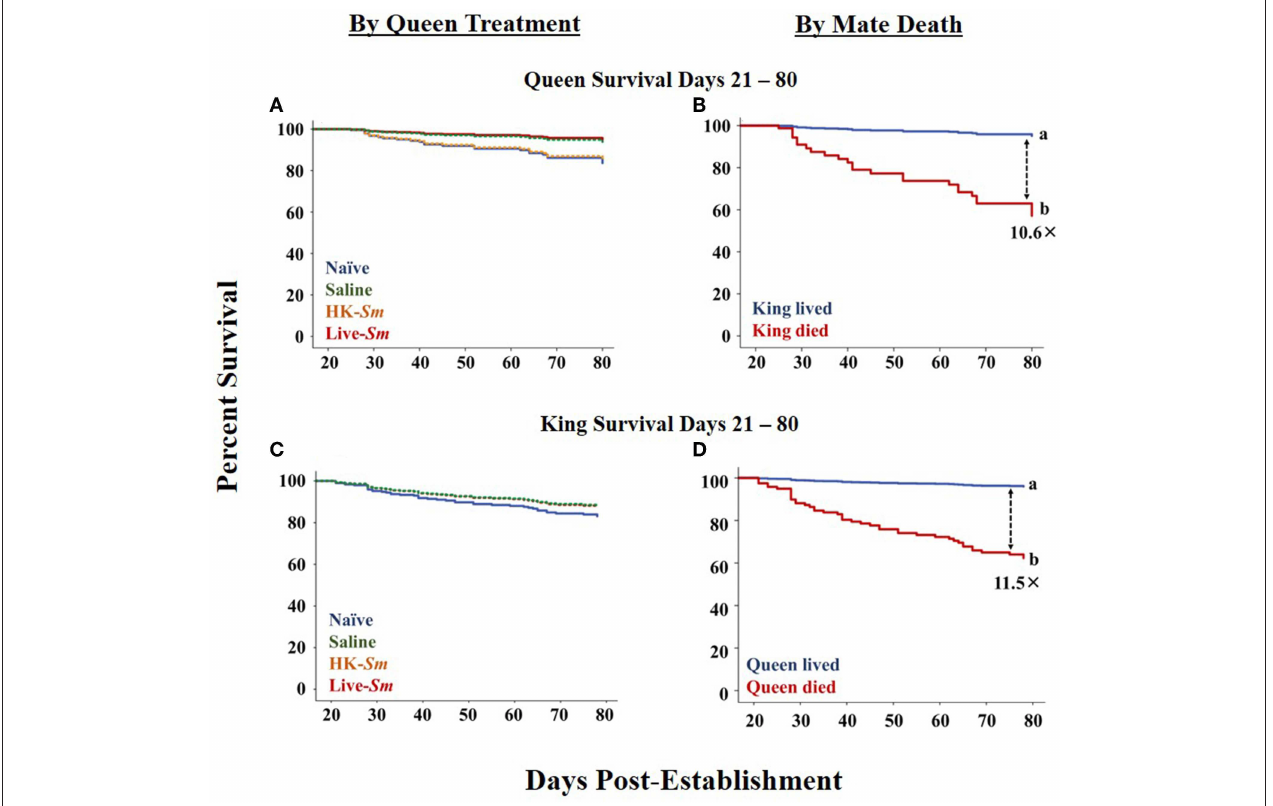
FIGURE 3 | Survival curves across days 21–80 post-establishment (Cox model). (A) Queen survival as a function of queen treatment. The survival curves for live- Sm and saline, and the naive and HK- Sm, treatments overlap. (B) Queen survival as a function of king death. (C) King survival as a function of queen treatment. The survival curves for kings mated to saline, HK- Sm and live- Sm queens overlap, and resemble a single line. (D) King survival as a function of queen death. Dashed arrows with corresponding numbers indicate hazard ratios of death between significant pairwise comparisons. Note that the magnitude of the hazard ratios of death when an individual’s mate dies (B and D) are an order of magnitude higher on days 21–80 post-establishment than on days 0–20 ( Figures 2B,D